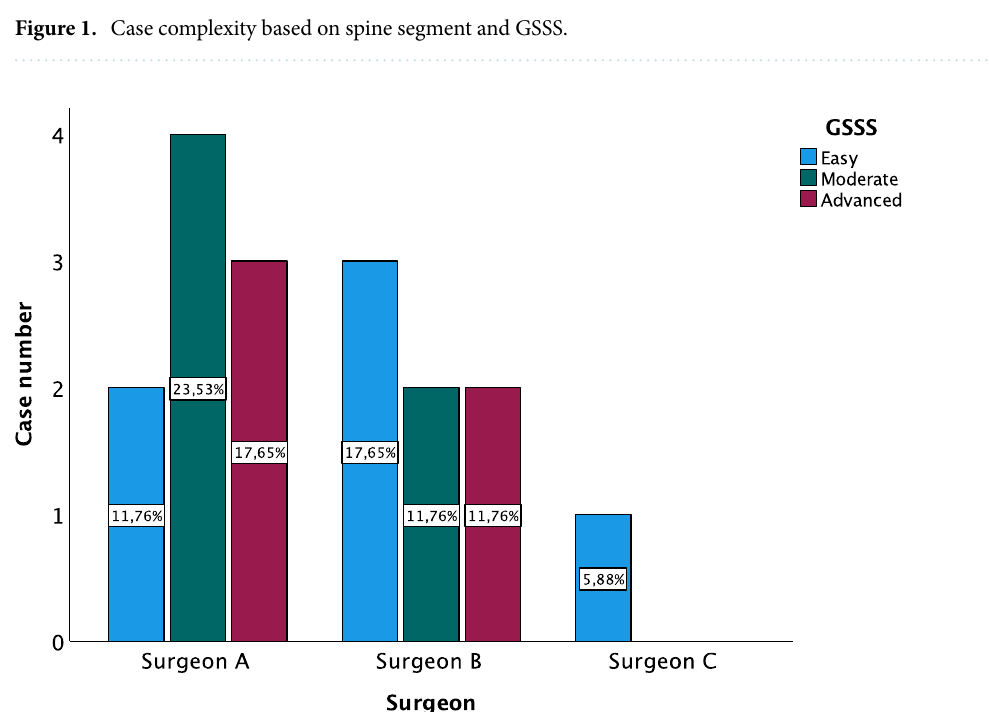
Figure 2. Case complexity distribution between surgeons based on